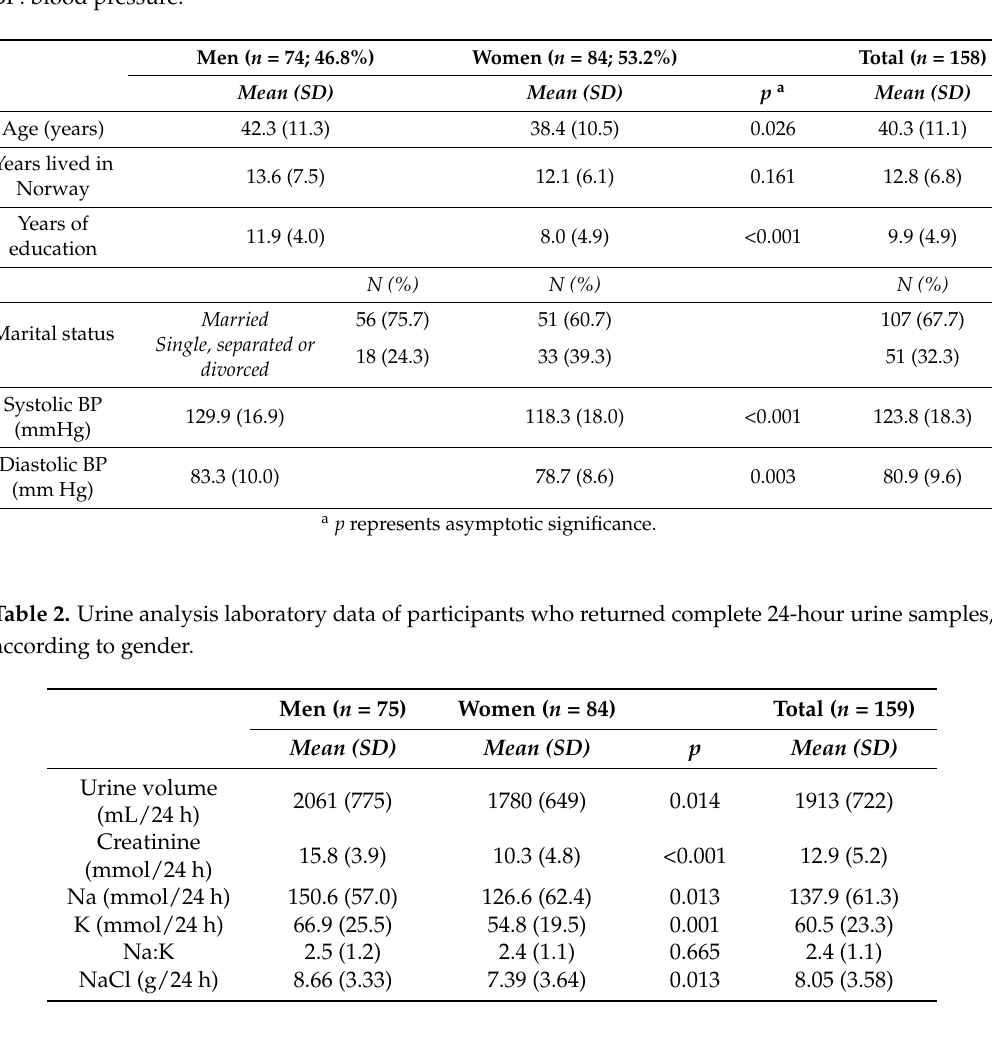
Clinical and demographic characteristics of participants, according to gender. BP: blood pressure.